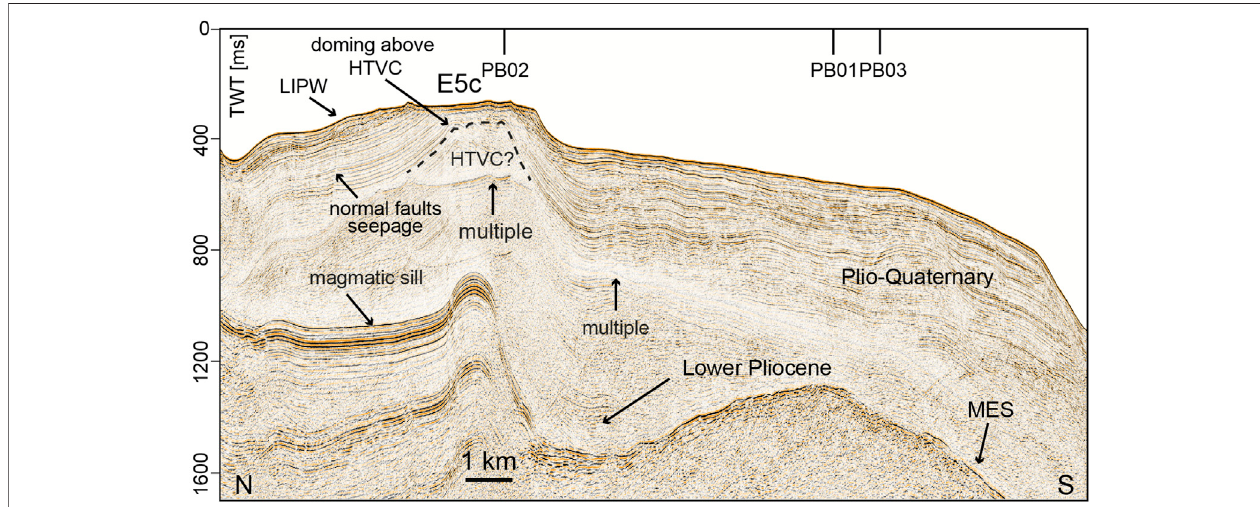
FIGURE 3 | Seismic re fl ection pro fi le PB12 showing the vertically-stacked magmatic sills and the southward change in seismic facies of the upper Messinian units (MES). Location in Figure 2A .